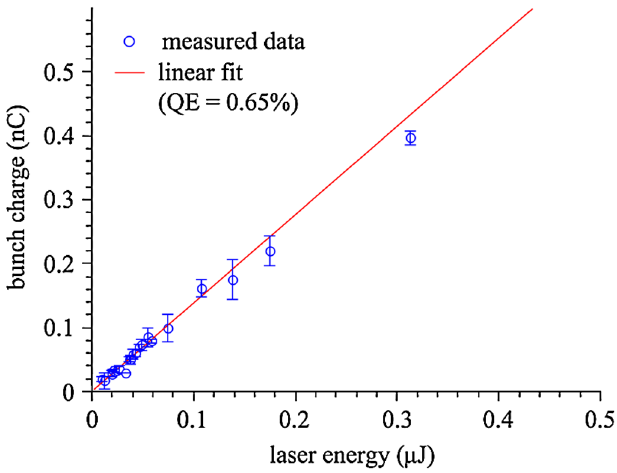
FIG. 12. (Color) QE maps of Cs Te photocathode #90.1 before 2 (a) and after (b) operation in the linac (the color scale indicates the relative QE and is normalized separately for the two mea-